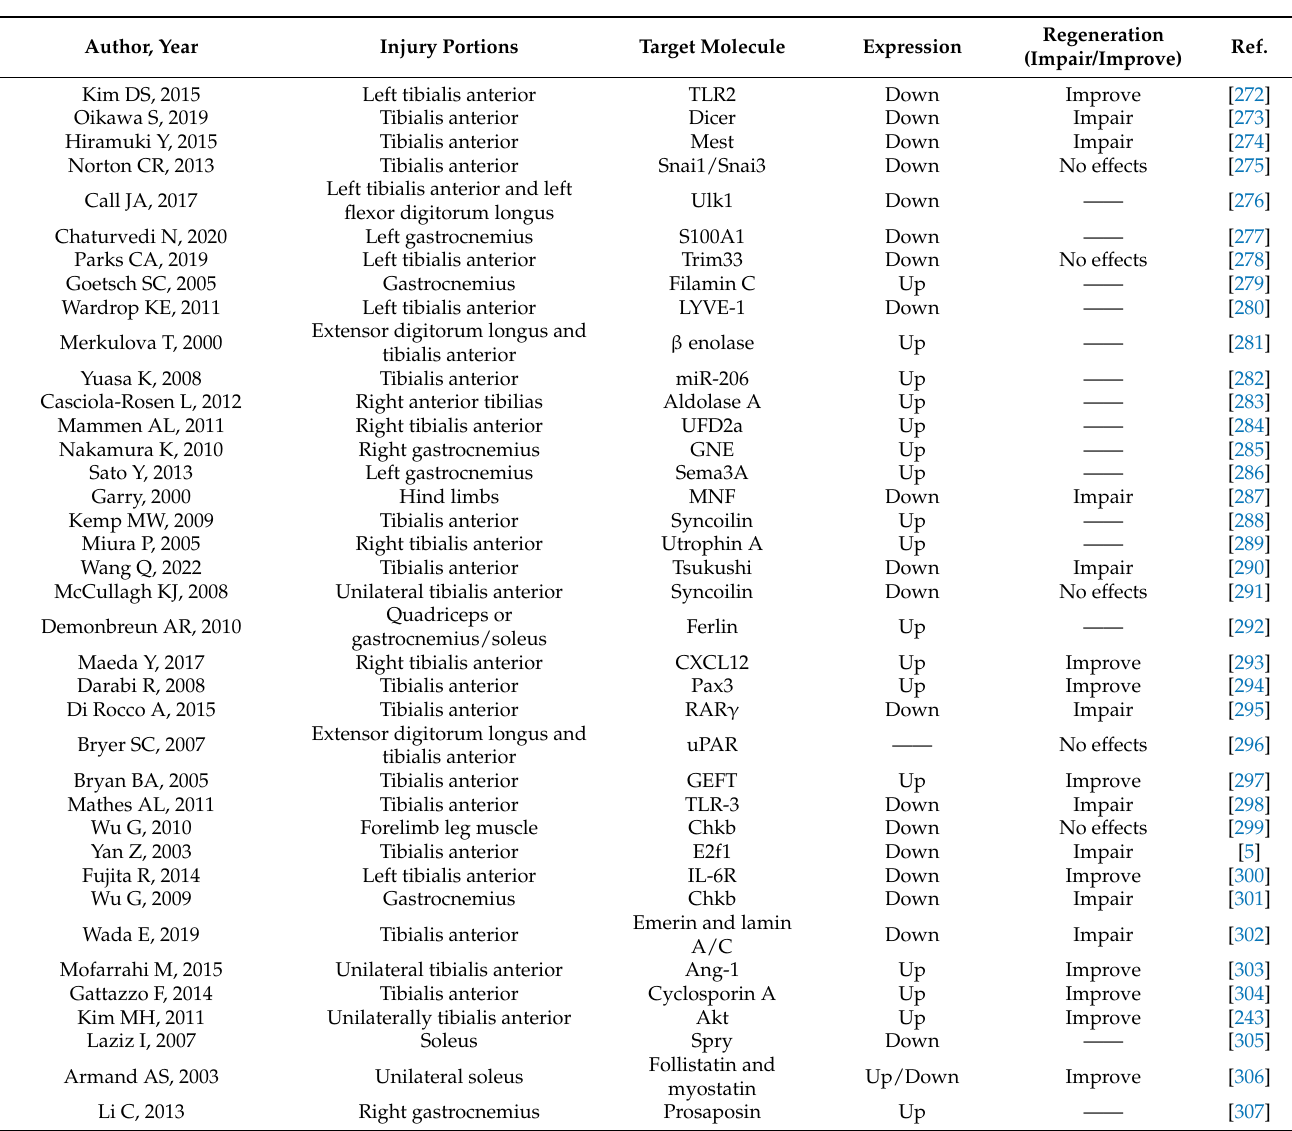
Table 6. Single gene in the CTX-induced skeletal muscle injury